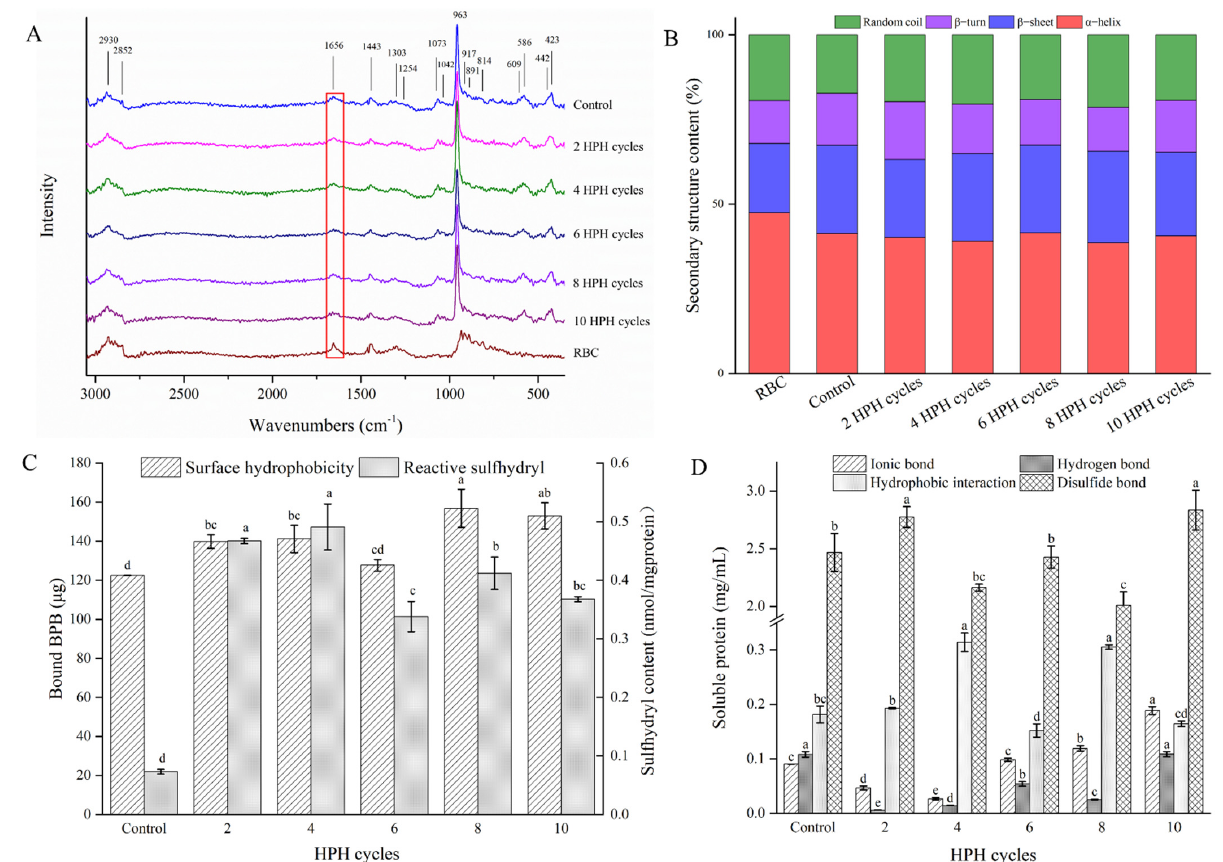
Figure 5. Chemical structures and intermolecular chemical forces of RBASs under different HPH cycles. ( A ) Raman spectra of RBC and RBASs. ( B ) Secondary structures of proteins in RBAS. Effect of HPH on the surface hydrophobicity, reactive sulfhydryl content ( C ) and intermolecular chemical force ( D ) of proteins in RBASs. In figure, different lowercases in each group showed significant differences ( p < 0.05).